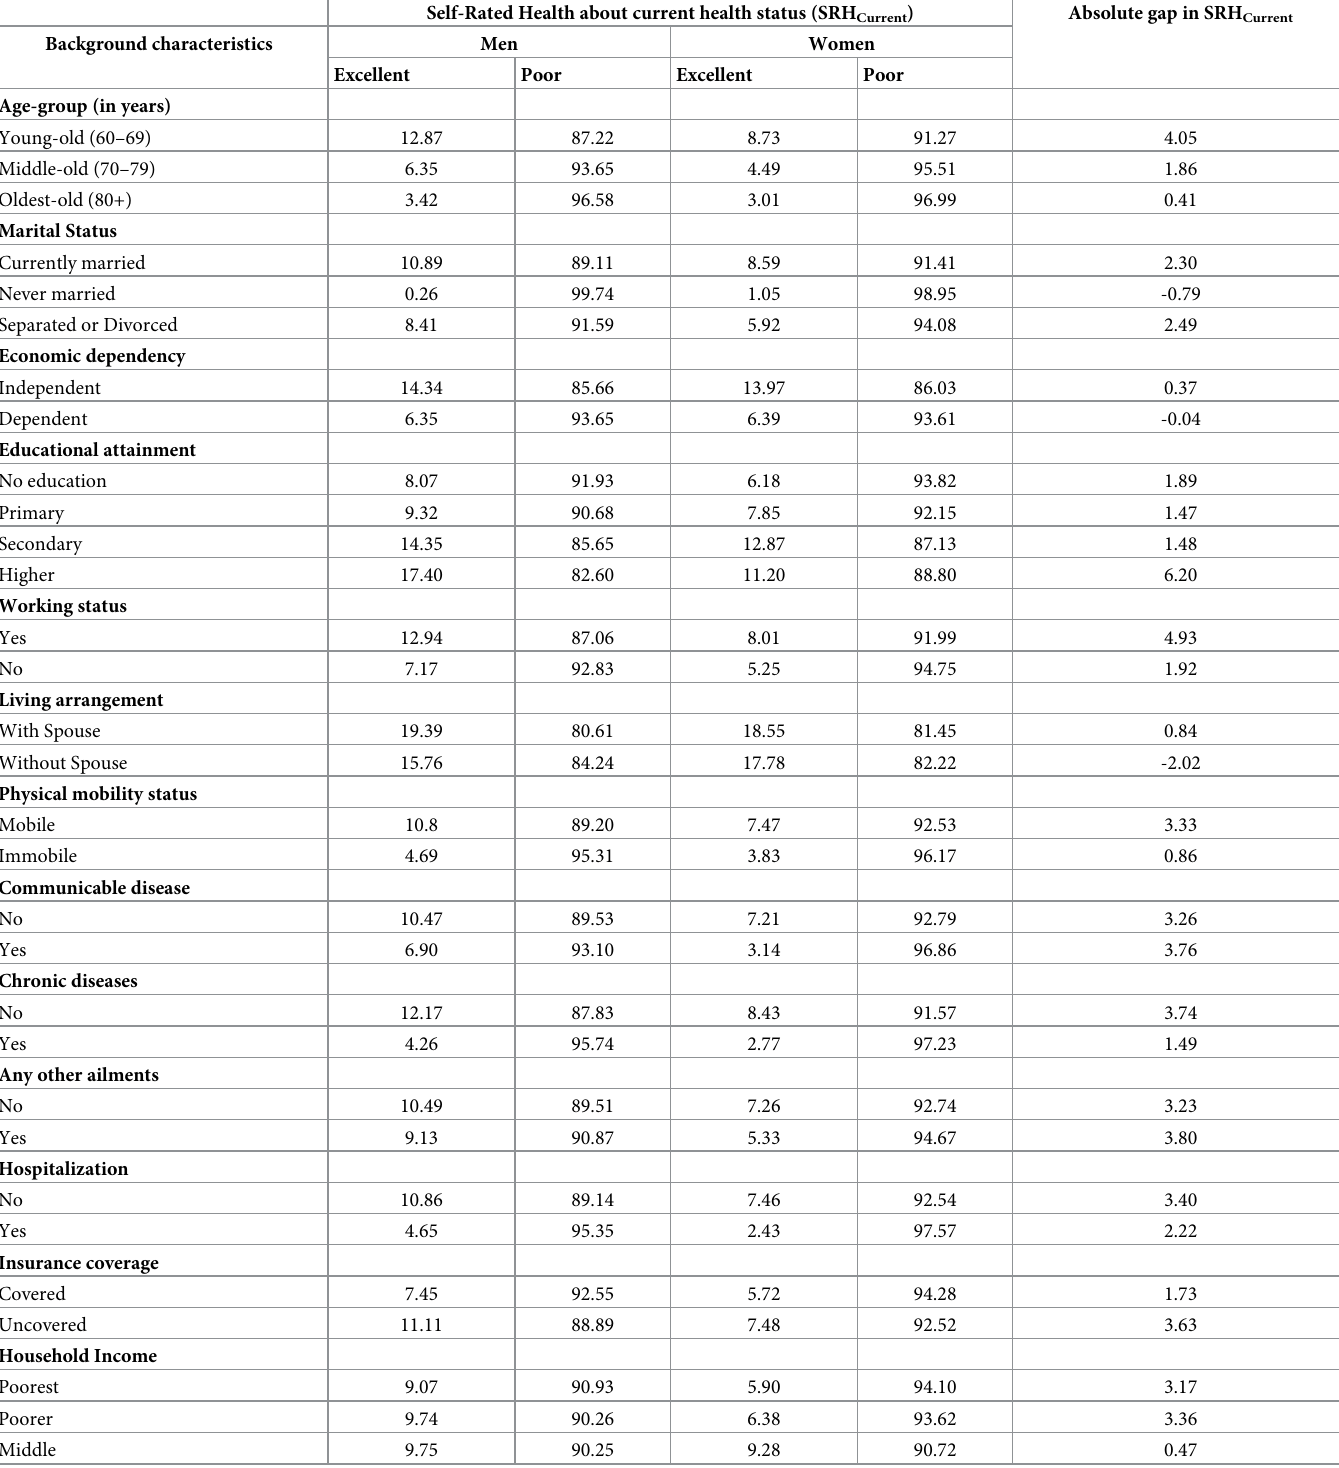
Table 2. Absolute gender gaps (%) in Self-Rated Health (SRH) about current health status among older adults in India by gender with suitable background charac- teristics, 2017–18 (n =